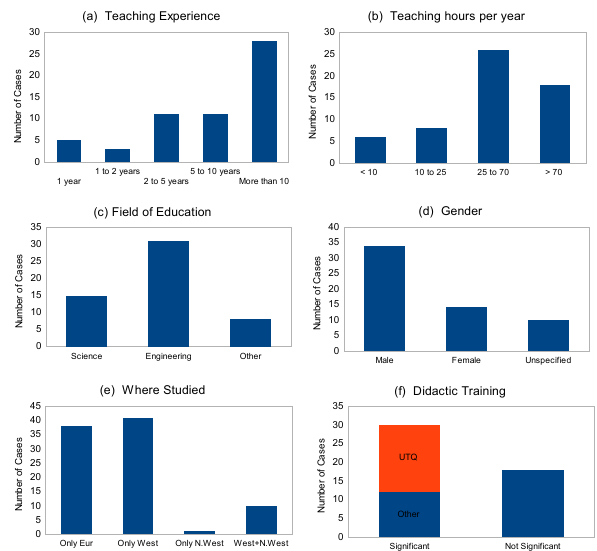
Fig. 1. Basic statistics of the survey sample. (a) Number of years of teaching experience. (b) Current hours taught per year. (c) Field of undergraduate degree of the respondent. (d) Gender. (e) Region where educated (school, undergraduate and postgraduate). (f) Didactic training. Significant: who have undergone significant didactic training (includes UTQ graduates and those who responded as possessing significant didactic training from other sources). Non Significant: those who do not have undergone significant didactic training.